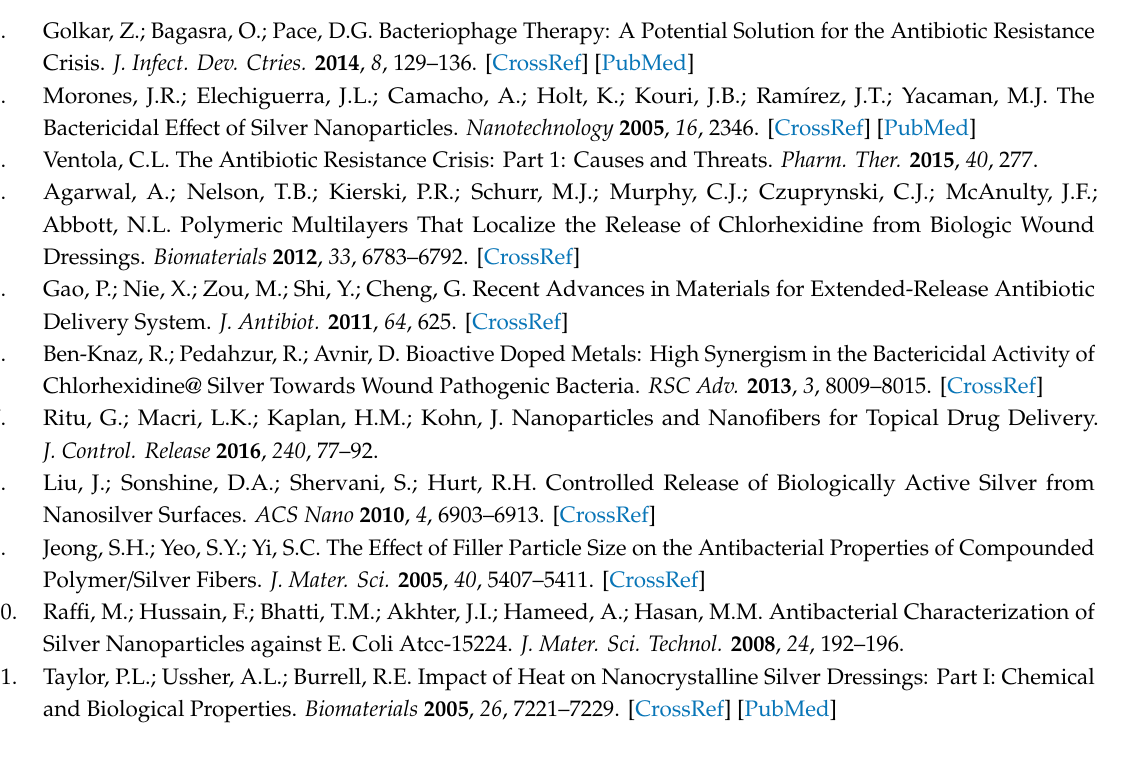
Table S1: Antimicrobial activity of Silver treated bacteria (killed bacteria and the supernatant) on Ps. aeruginosa, E. coli O157:H7 and MRSA using well agar di ff usion